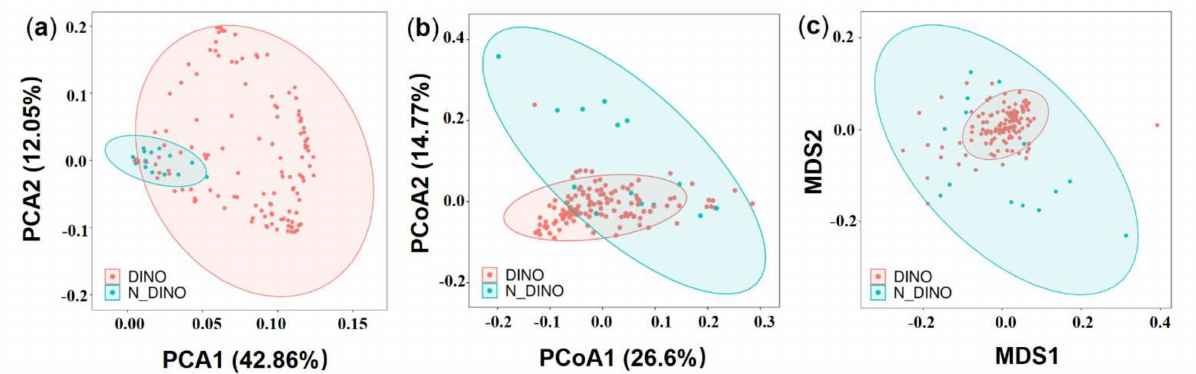
Figure 3. The beta diversity analysis of DINO (light red) and N-DINO (light blue) groups. ( a ) Principal component analysis (PCA) using genus/species-level Hellinger transformed relative abundances of bacterial sequences. ( b ) Principal coordinate analysis (PCoA) using weighted − unifrac distances. ( c ) Non-metric multidimensional scaling (NMDS) plot based on the weighted − unifrac distance using the Bray–Curtis similarity